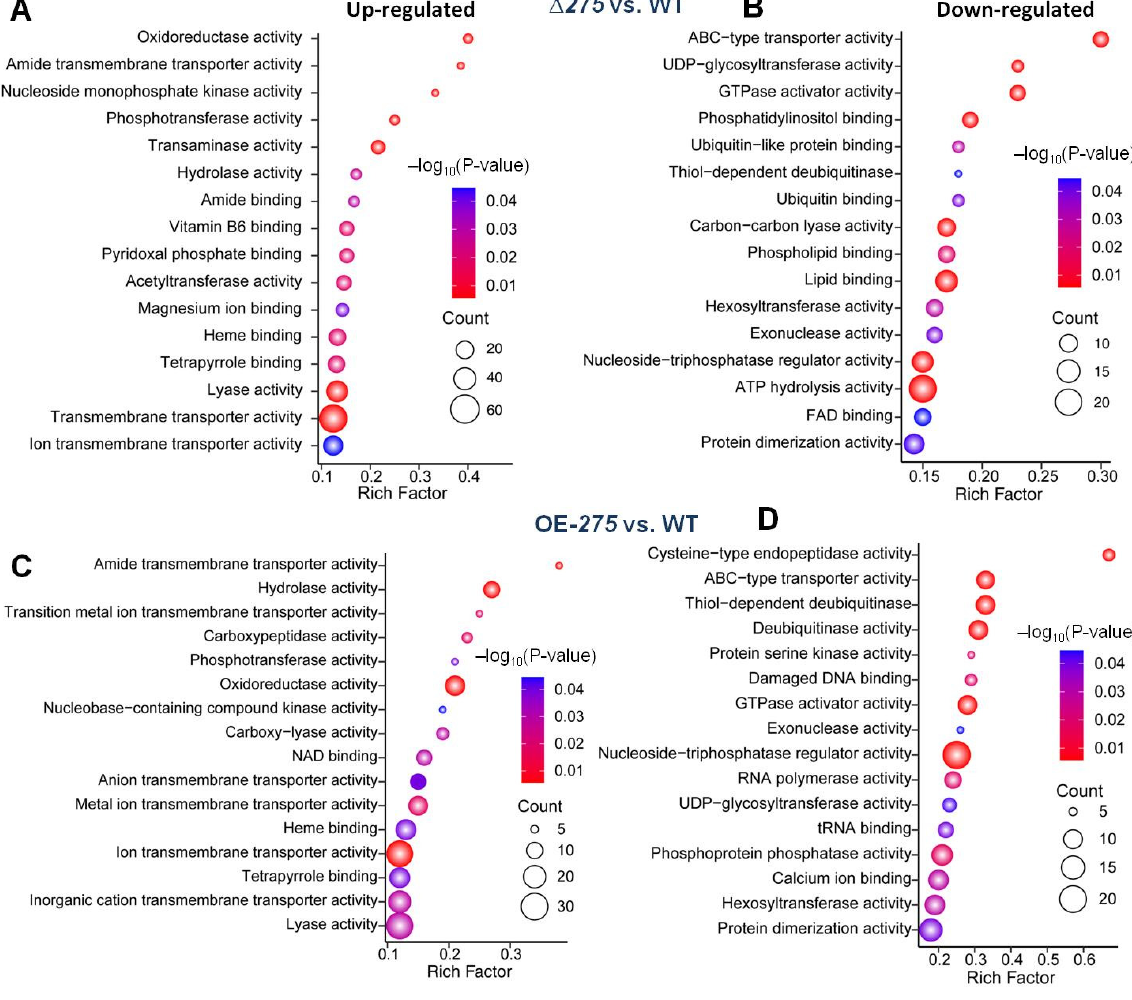
Figure 6. GO analysis of the significantly differentially regulated genes in Δ 275 and OE-275, com- pared to the WT: ( A , B ) GO analysis of the significantly upregulated genes ( A ) and downregulated genes ( B ) in Δ 275 vs. the WT. ( C , D ) GO analysis of the significantly upregulated genes ( C ) and downregulated genes ( D ) in OE -275 vs. the WT.